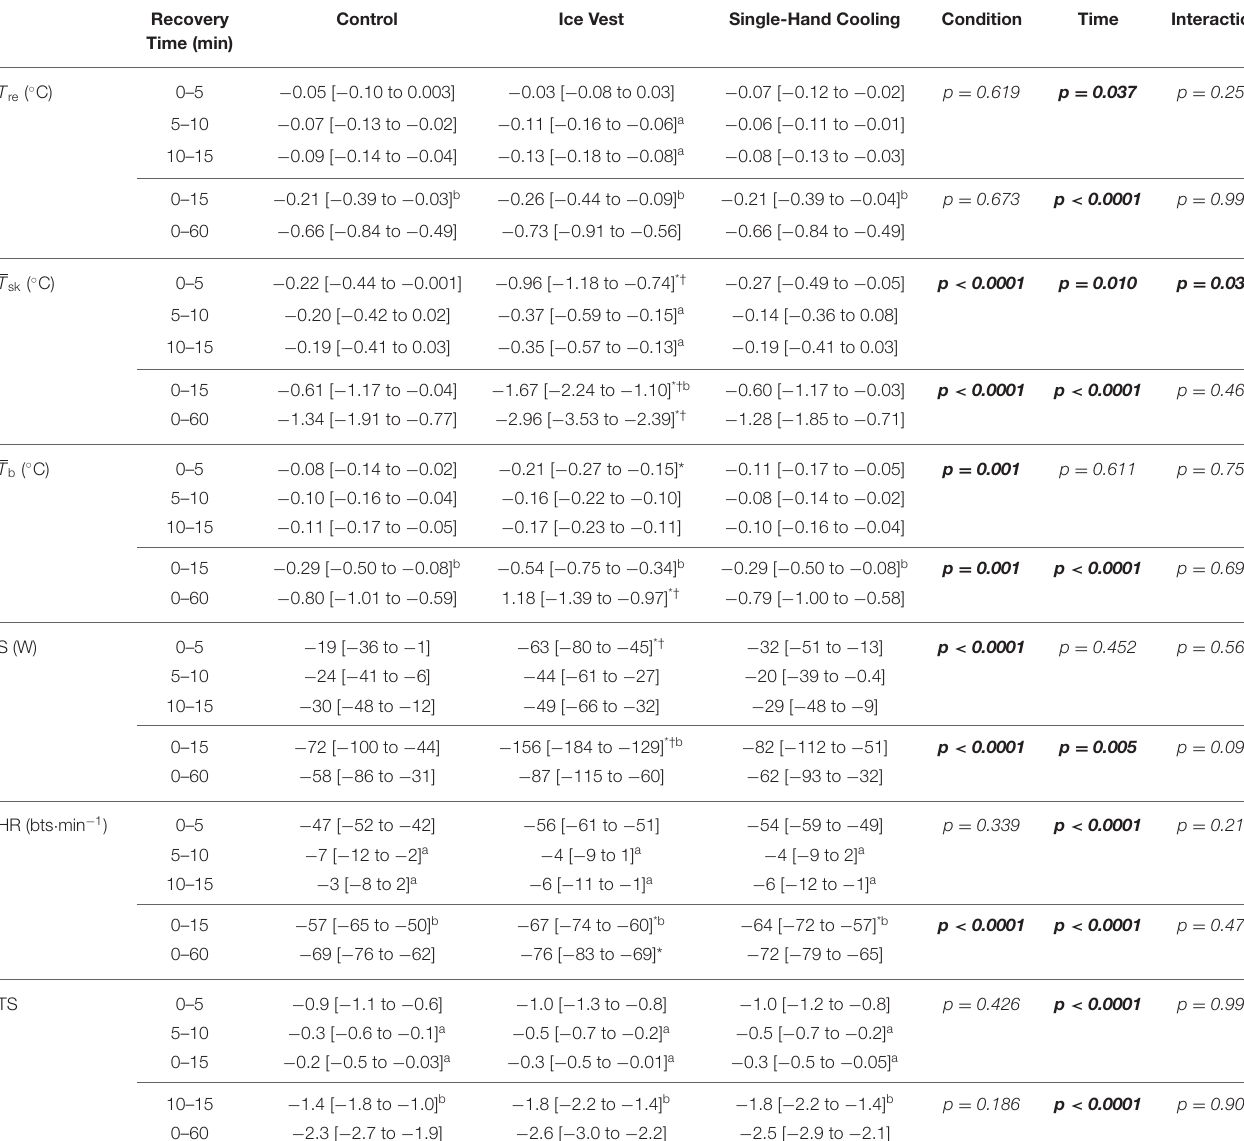
TABLE 1 | Delta mean [95% confidence interval] rectal temperature ( T re ), skin temperature ( T sk ), body temperature ( T b ), stored heat ( S ), heart rate (HR), and thermal sensation (TS) during prolonged recovery (REC 0 − 60 ), and time-limited recovery (REC 0 − 15 ) with 5min block component analysis (REC 0 − 5 , REC 5 − 10 , REC 10 − 15 ) when using a non-cooled control, ice vest, and single hand-cooling during heated exercise recovery. Recovery Control Ice Vest Single-Hand Cooling Condition Time Time (min)